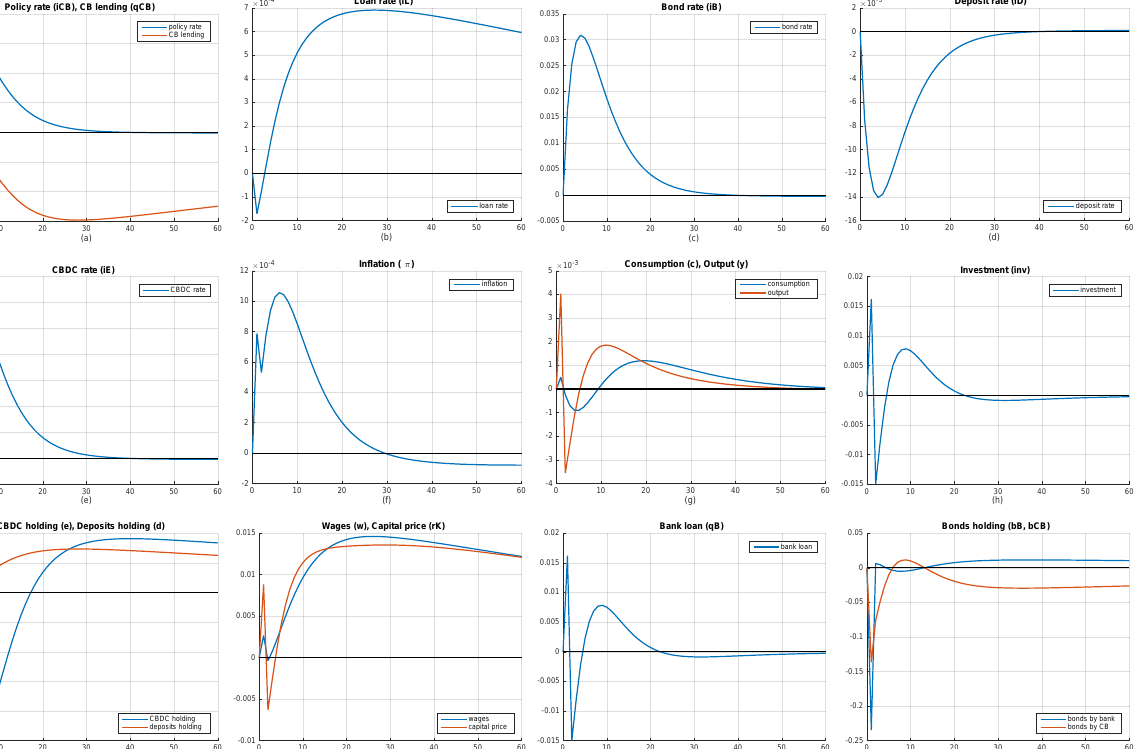
and central bank lending q CB t , ( e ) CBDC rate i E , ( f ) inflation π t , ( g ) consumption t t , b CB t t